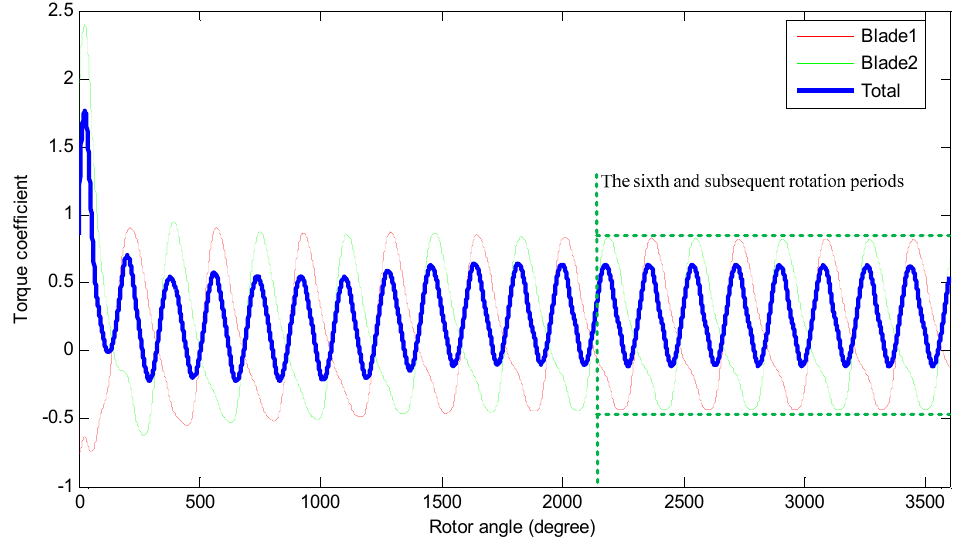
Figure 8. The torque coefficient during 10 rotation periods at TSR = 1.0 in the process of computational fluid dynamics (CFD) simulation.